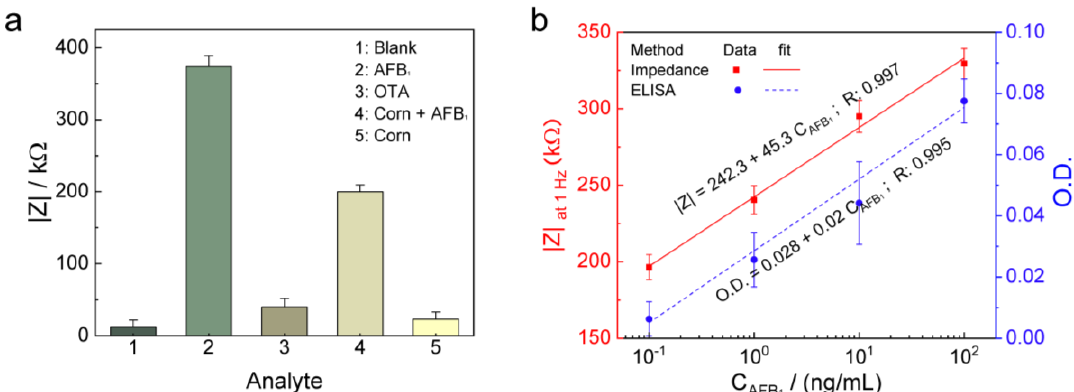
Figure 6. ( a ) Selectivity of the developed sensor demonstrated by impedance measurements with various types of the analyte to examine the cross-reactivity of the AFB 1 sensor; ( b ) impedance change and optical density (O.D.) obtained by ELISA versus AFB 1 concentrations (0.1 to 100 ng/mL).